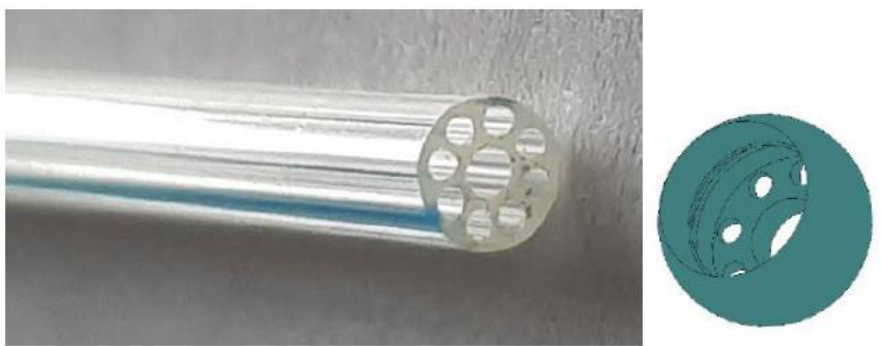
Figure 8. Left : multilumen cannula, Microspec Corporation. Right : right spherical made.